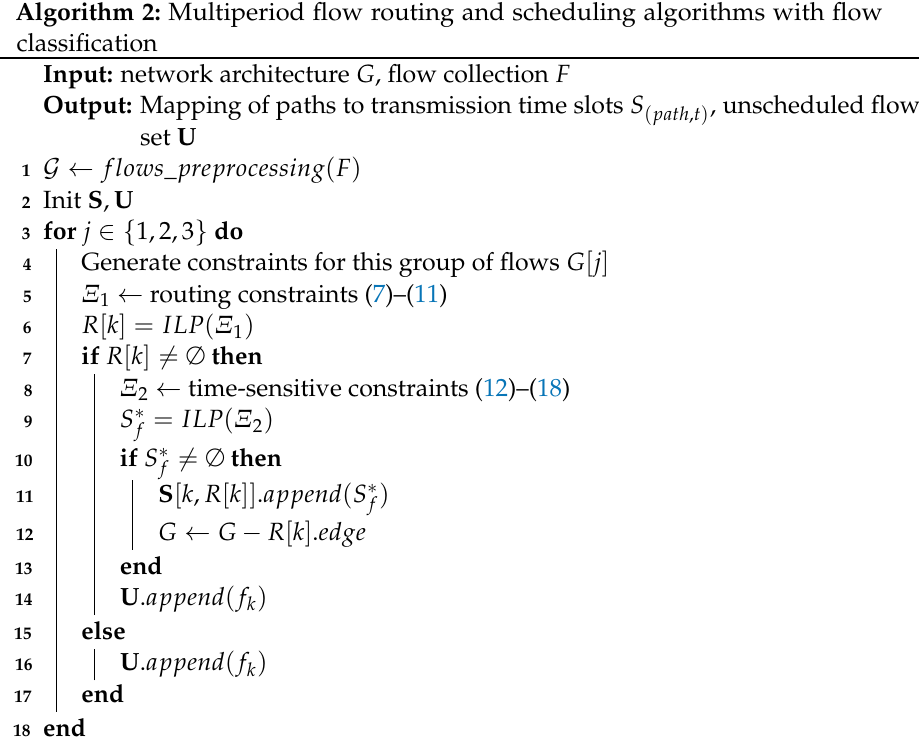
Algorithm 2: Multiperiod flow routing and scheduling algorithms with flow